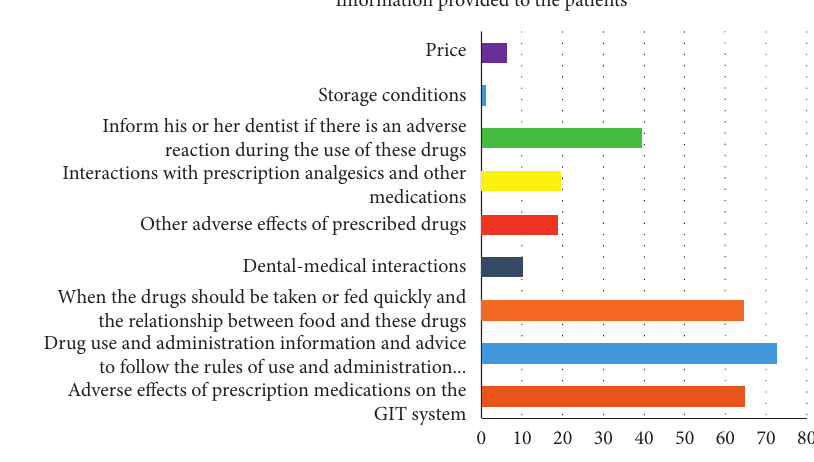
Figure 1: Information provided to the patients.